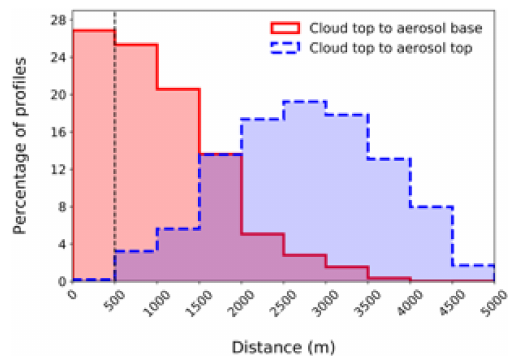
Figure 15. Analysis of the vertical gap that is apparent between underlying clouds and overlying BBA observed using the CATS li- dar. The data analysed are for July, August, and September in the years 2014–2017. All profiles are within the area 20 ◦ S–5 ◦ N and 10 ◦ W–15 ◦ E and are taken from retrievals where there is a single liquid cloud layer below 2.5km and a single BBA layer in the same profile. The solid red line corresponds to the distance between cloud top and BBA base (percentage of occurrence is for all profiles), and the dashed blue line corresponds to the distance between cloud top and BBA top (percentage of occurrence only for profiles where the BBA layer is above the cloud). The dashed black line at 500m highlights the distance beyond which LES simulations by Herbert et al. (2020) suggest there is little or no